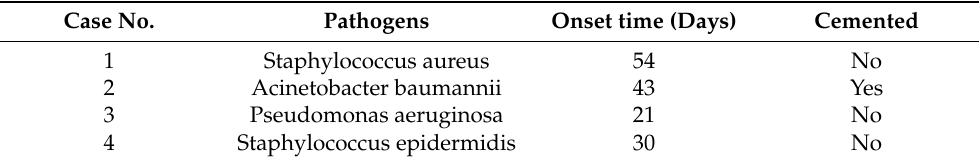
Table 3. The pathogens and onset time of the four infections.